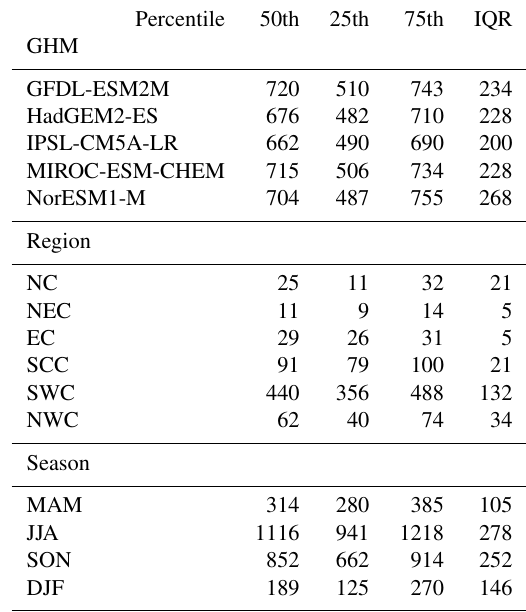
Table 1. Estimates of annual and seasonal GHP (GW) for regions and China over